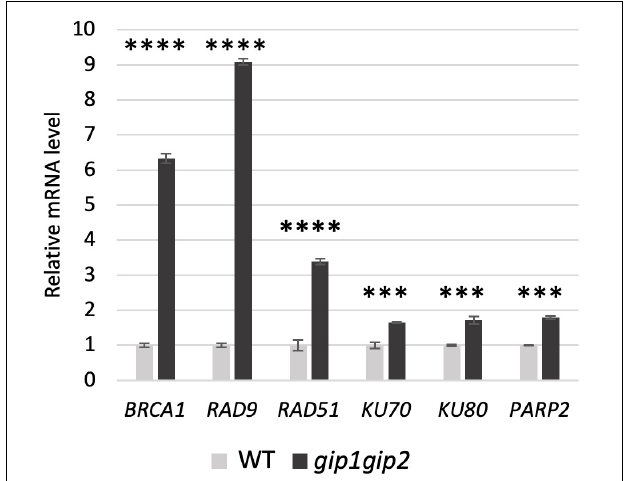
FIGURE 3 | mRNA level of DNA damage responsive genes in gip1gip2. Relative mRNA level of selected DNA damage responsive genes in gip1gip2 was compared to WT. Experiments of RT-qPCR was performed on RNA isolated from 9-day-old seedlings using specific set of primers (see Supplementary Table 1 ). Two independent experiments were performed. SDs are indicated. Unpaired t test was used where p -values are indicated as < 0.0001 ( ∗∗∗∗ ) and < 0.001 ( ∗∗∗ ), respectively.